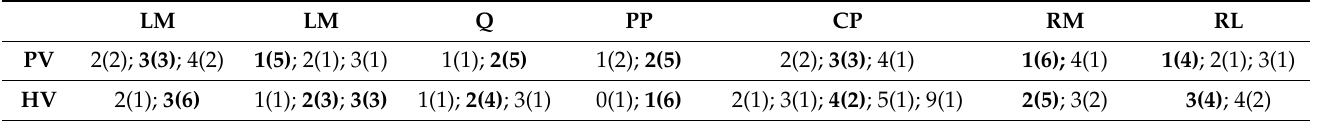
Table 1. Number of tertiary portal (PV) and hepatic vein (HV) branches supplying each